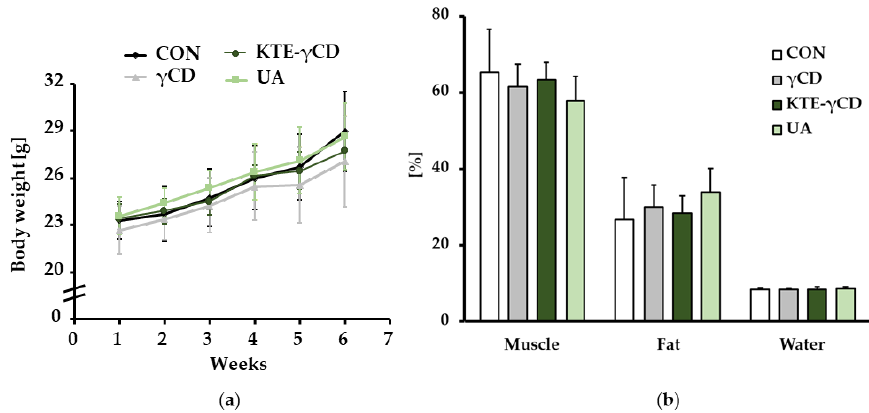
Figure 2. Effect of γ-cyclodextrin ( ɣ CD), Kuding tea extract- ɣ CD (KTE- ɣ CD) and ursolic acid (UA) on body weight development and body composition. Mice were fed (ad libitum) the following diets for 6 weeks: a high-fat, high-fructose, Western-type diet (CON, control), 12.88% γCD, 7.12% KTE encapsulated in 12.88% γCD (KTE-γCD) or 0.15% UA. ( a ) Body weight development and ( b ) body composition. Data are expressed as the mean ± SD ( n = 8–10 mice/diet). Statistical analyses of body weight repeated measures after checking for sphericity, followed by the Bonferroni post hoc test (time p <